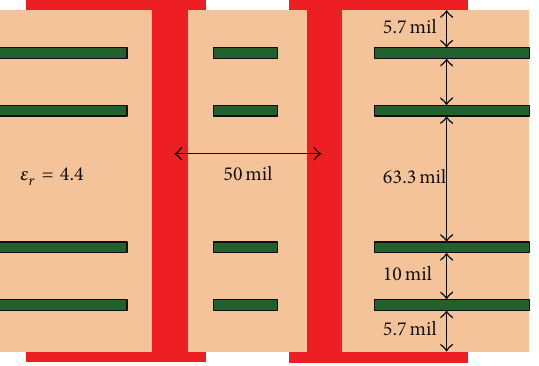
Figure 21: Side view of differential vias structure in